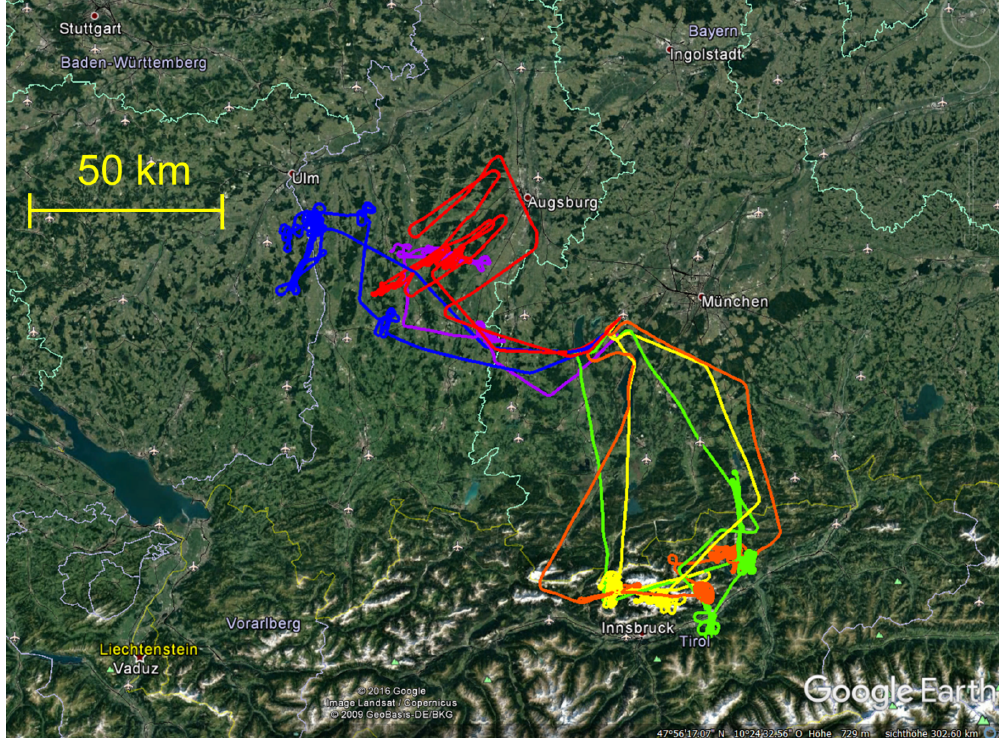
Figure 3. Overview of the target region for the measurement flights above the northern Limestone Alps and foothills west of Munich. The lines show the six flights listed in Table 2 coloured blue, red, orange, yellow, green and purple in order. The thin yellow line marks the border between Austria and Germany (©2016 Google, Image Landsat/Copernicus).